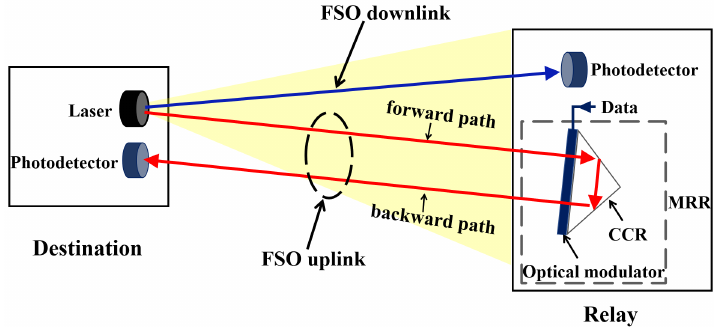
Figure 2. Schematic diagram of MRR FSO with bidirectional